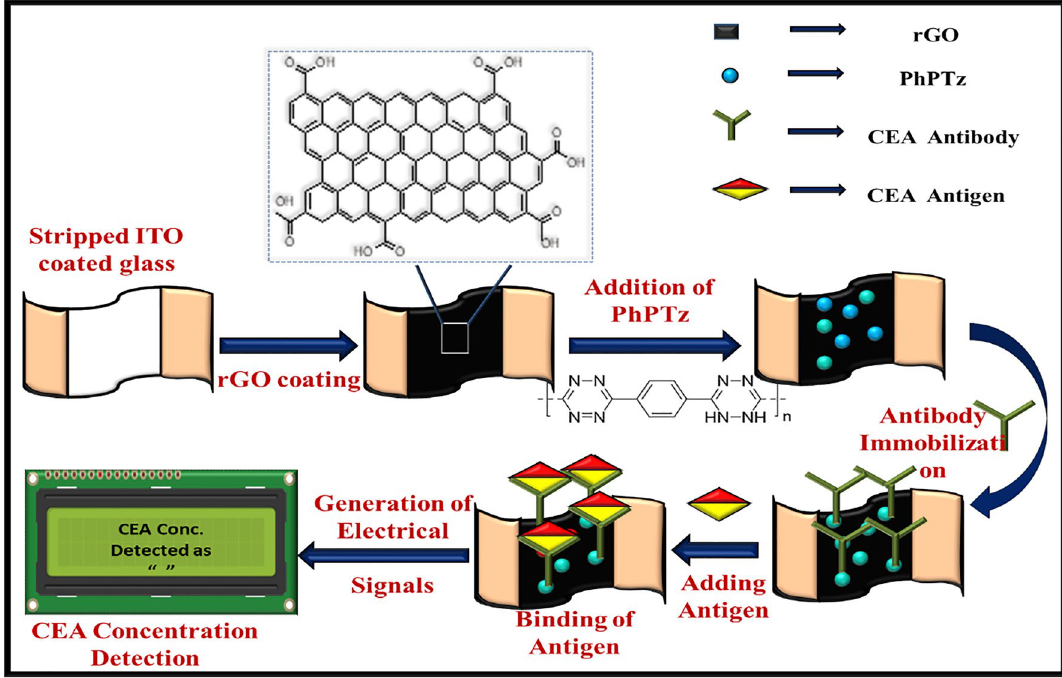
Figure 1. Schematic showing fabrication steps of the electronic